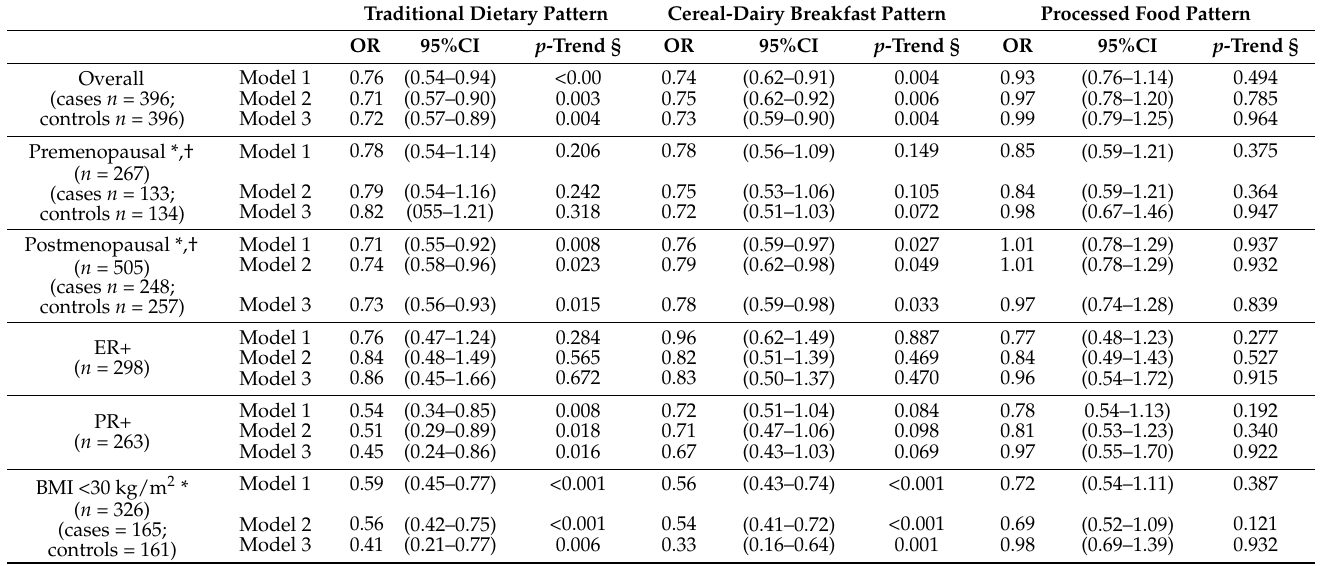
Table 3. The association between the three retained dietary patterns (highest tertile versus lowest tertile) and breast cancer